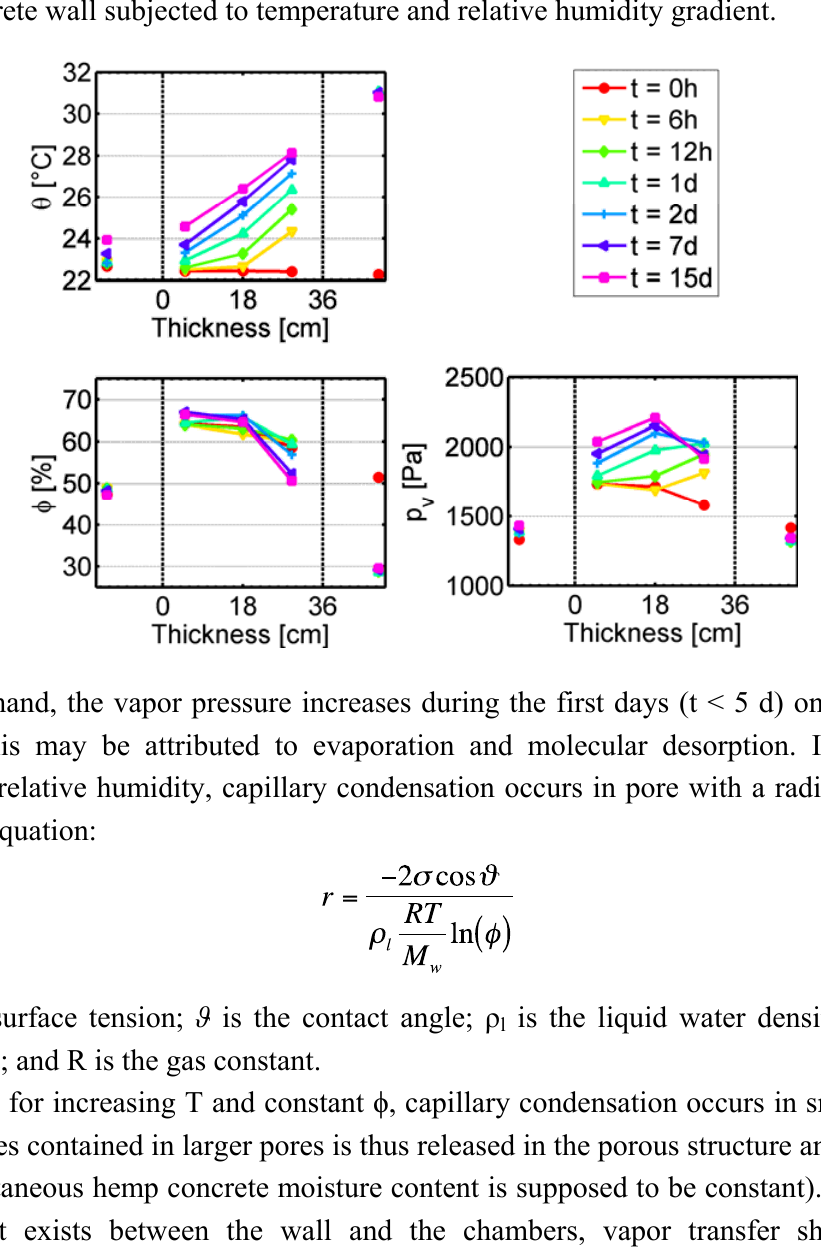
Figure 6. Spatial response in θ , ϕ and p at t = 0, 0.25, 0.5, 1, 2, 7 and 15 days of uncoated v hemp concrete wall subjected to temperature and relative humidity